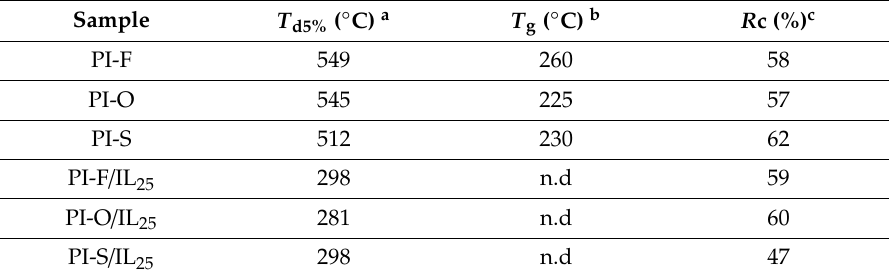
Figure 4. TGA and DTGA curves of the synthesized PIs ( a ) and PI / IL films ( b ). Table 4. Thermal properties of PIs and PI / IL films a under nitrogen